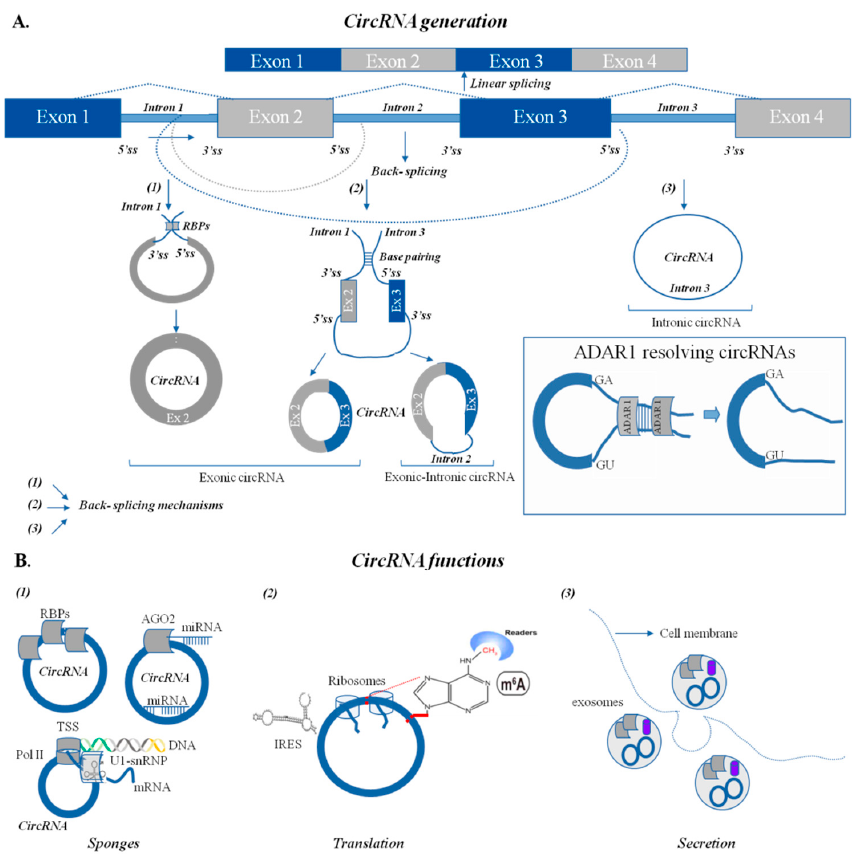
Figure 1. Mechanisms that lead to back-splicing events and circRNA functions. ( A ). (1) The first mechanism involves RNA-binding proteins (RBPs); binding to the flanking intron creates a closed loop that brings the complementary splice donor and acceptor sites close. As a result, an exonic- circRNA is generated. (Ex: exon) (2) The second form of back-splicing has to do with complementary introns within ALU repeats that bring the exons closer, resulting in the formation of either exonic circRNAs initiated by the 3 ′ end exon splice donor site joined to the 5 ′ end of an upstream exon or the 3 ′ end exon splice donor site joined to the 5 ′ end of an upstream exon with a retained intron. The latter can also be formed via the binding of RBPs at the flaking intron position between exon 2 and 3. Consequently, exonic circRNAs or exonic-intronic circRNAs are generated. (3) The third type of back-splicing results only from intron pairing, where splicing is prompted by reverse complementary sequences within ALU repeats (located in the upstream and downstream introns). This process results in intronic circRNA production. Inset: The circular RNA formation can be degraded via ADAR1, whose binding at double stranded regions, such in the case of base-pairing introns within ALU repeats, can break-down the circular formation [27]. ( B ). CircRNAs function as: (1) sponges that bind proteins or other nucleic acids, (2) can be translated, and (3) are secreted via